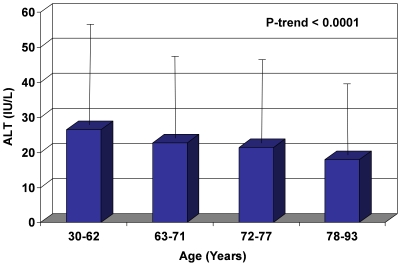
Effect of Age on ALT Values in Men (Mean and 95% Confidence Interval).In men, mean ALT (bars) and 95th percentile cutoff ranges (extension lines) both decrease with rising age.